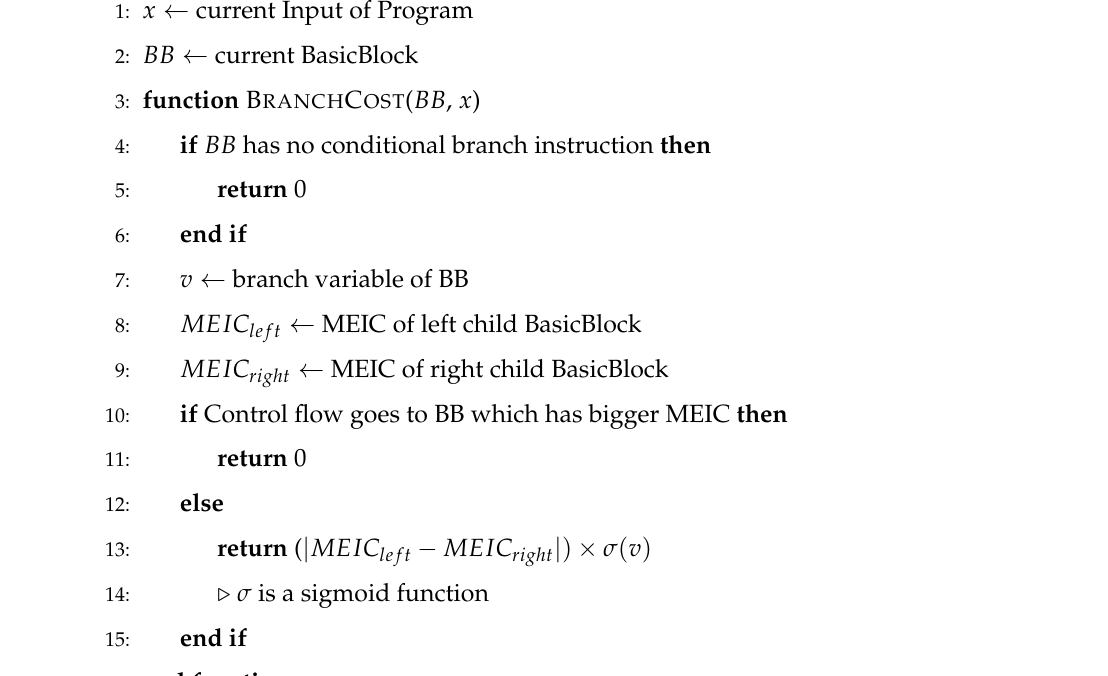
Algorithm 5 Calculating branch